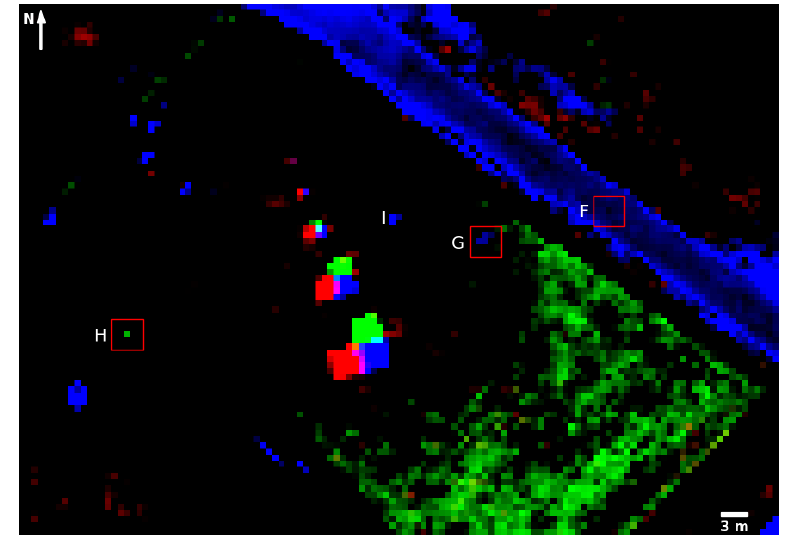
Figure 20. Hidden target detection through spectral unmixing. The RGB composite shows the LASSO ( λ = 1) abundance maps for red metal (red), green fabric (green) and blue fabric (blue), clipped and displayed in logarithmic scale to facilitate the identification of hot spots. The red boxes are centered at the positions of the hidden targets (F, G, H) as inferred from the 3K image. The 0.5m hidden targets made of blue fabric (G) and green fabric (H) are fairly visible, while the 0.25m red metal piece (F) cannot be located. The SVC white panel (I) can be clearly seen in the blue fabric abundance